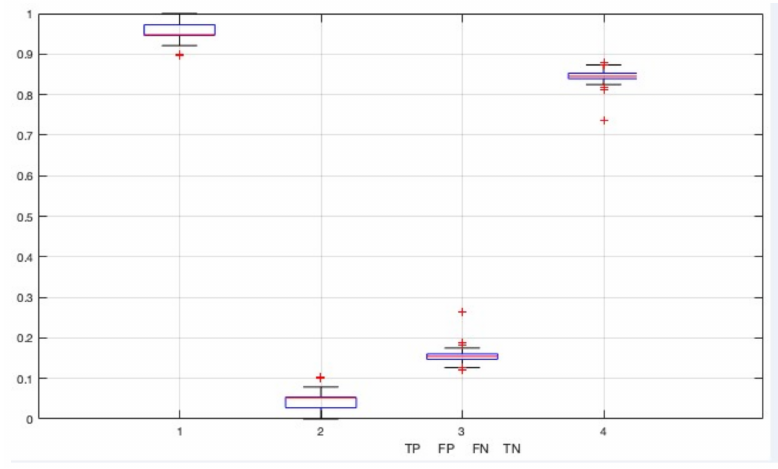
Figure 7. The box plots of TN , TP , FN , and FP statistics for PH2 database with ND = 20.